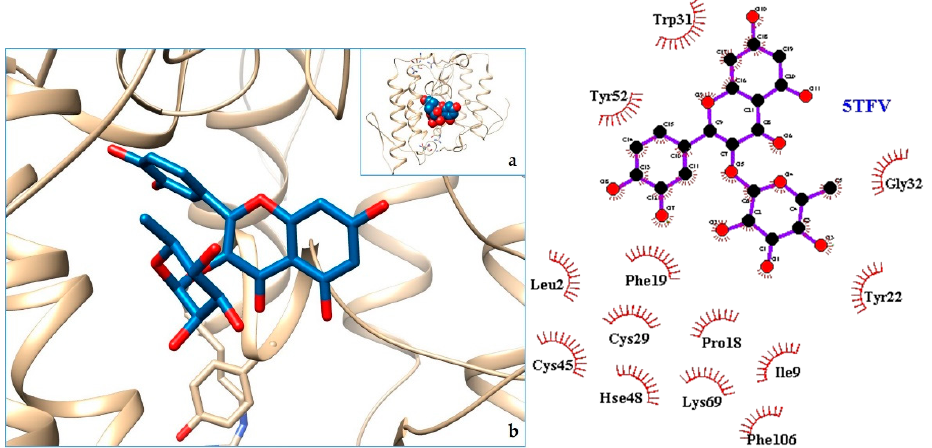
Figure 3. 5TFV-quercetrin complex. in the most favourable arrangement ( a ) and augmented ( b ) showing the disposition between the chain of toxins. Right: 2D interaction diagram.